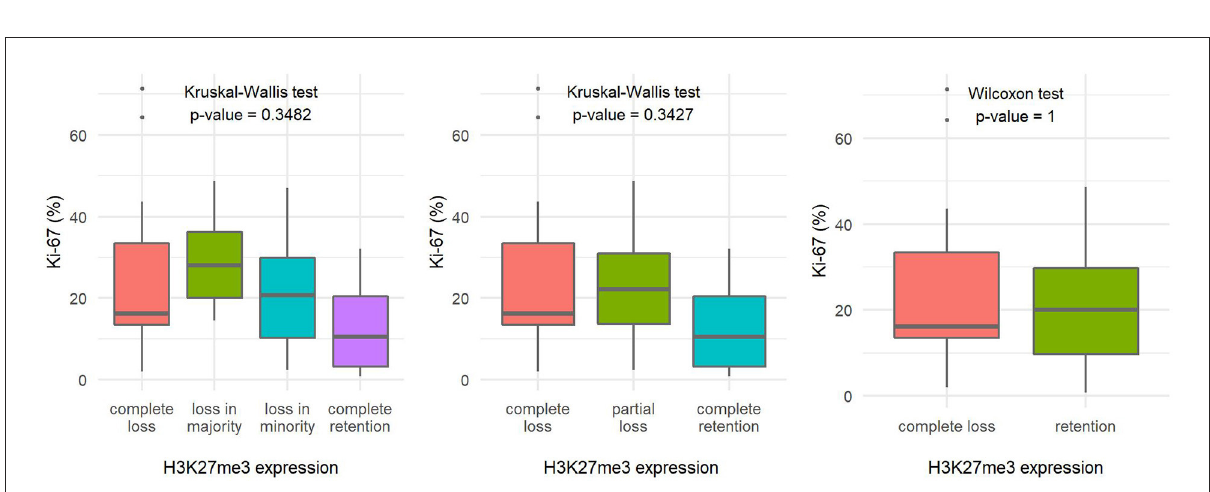
FIGURE5 Comparison of the Ki-67 proliferation index fields based on H3K27me3 expression using a 4-tier scoring scale (A) , a 3-tier scoring scale (B) , and a 2-tier scoring scale (C) , indicating the statistical test used and the corresponding p